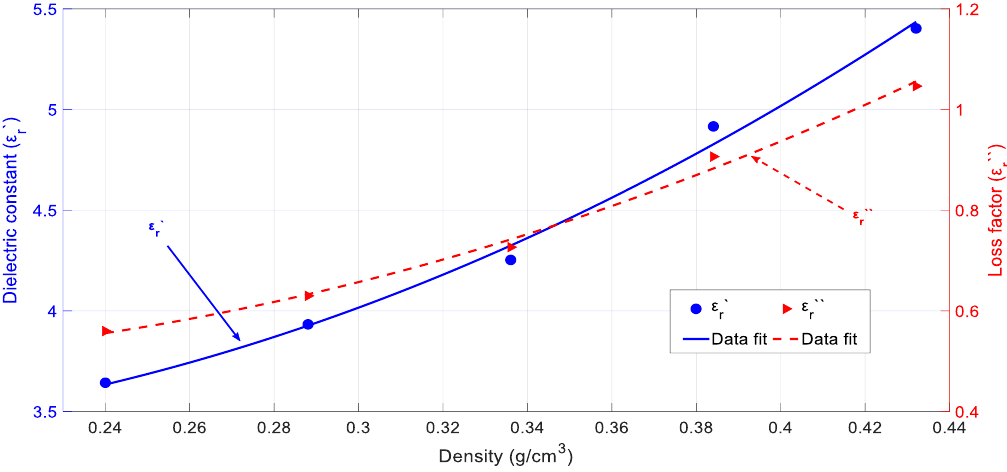
Figure 4. Dielectric properties for cypress depending on the sample density and polynomial fit at room temperature (28 °C) and an average moisture content equal to 100%.